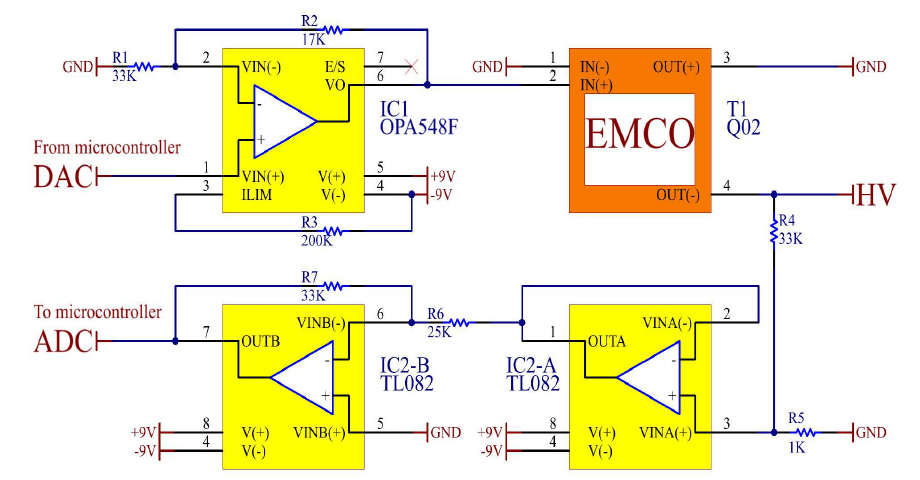
Figure 6. Circuit proposed for controlling the DC-HV DC